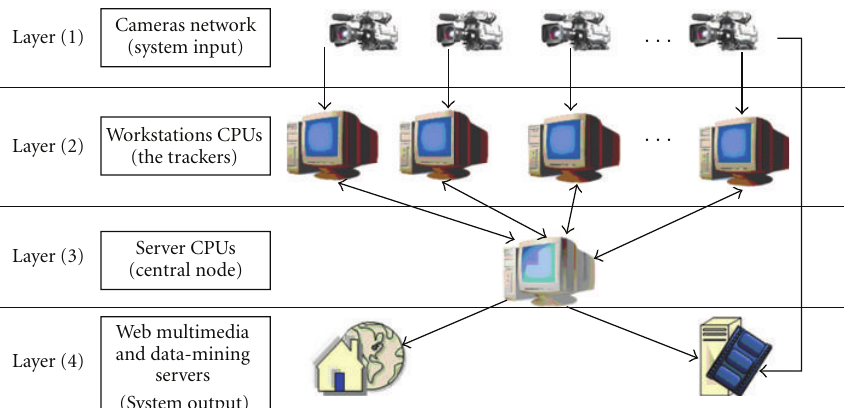
Figure 6: System architecture layers and elements.